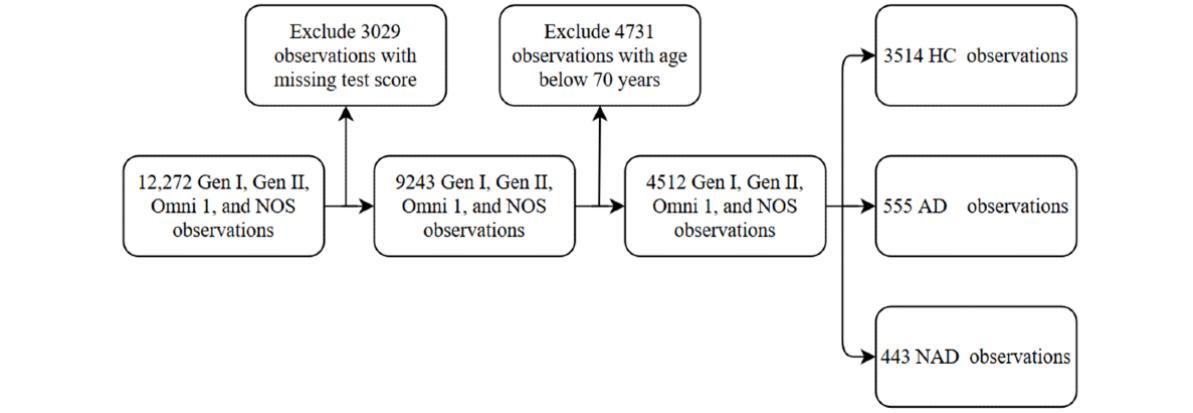
Figure 1. The process of sample selection. AD: Alzheimer disease; HC: healthy control; NAD: non-Alzheimer dementia; NOS: new offspring